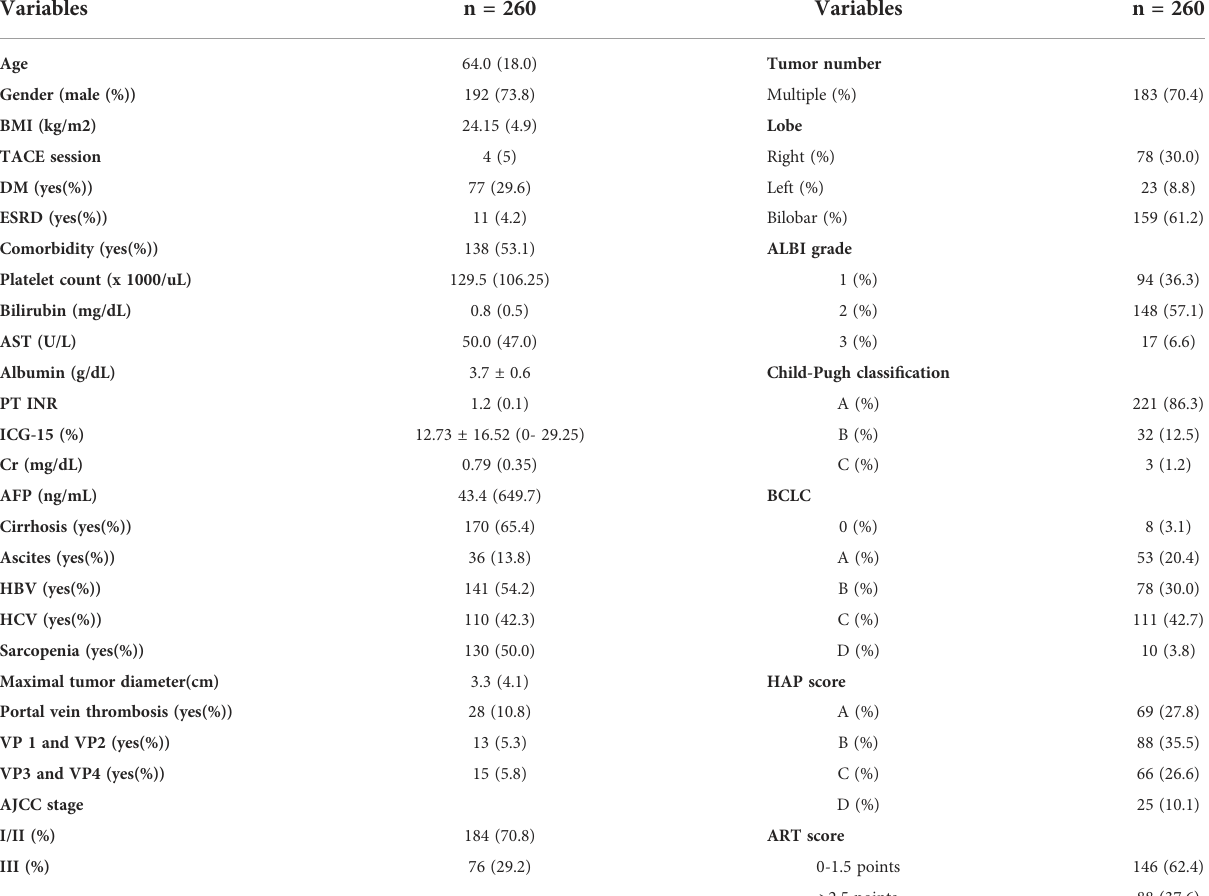
TABLE 1 Patient